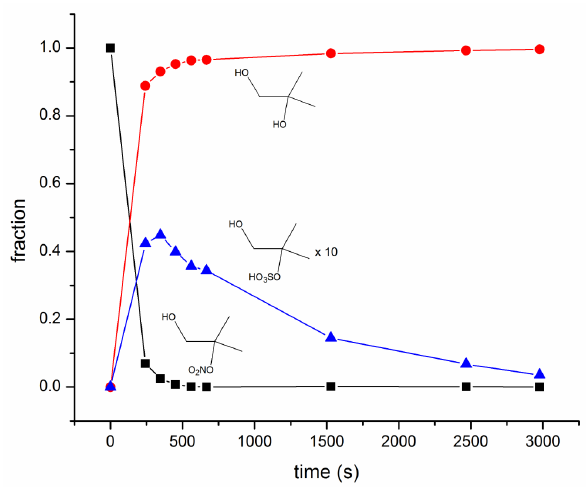
Fig. 2. Raw kinetics data for the reaction of 2-methyl-2-nitrato-1-propanol in 2 M D 2 SO 4 .